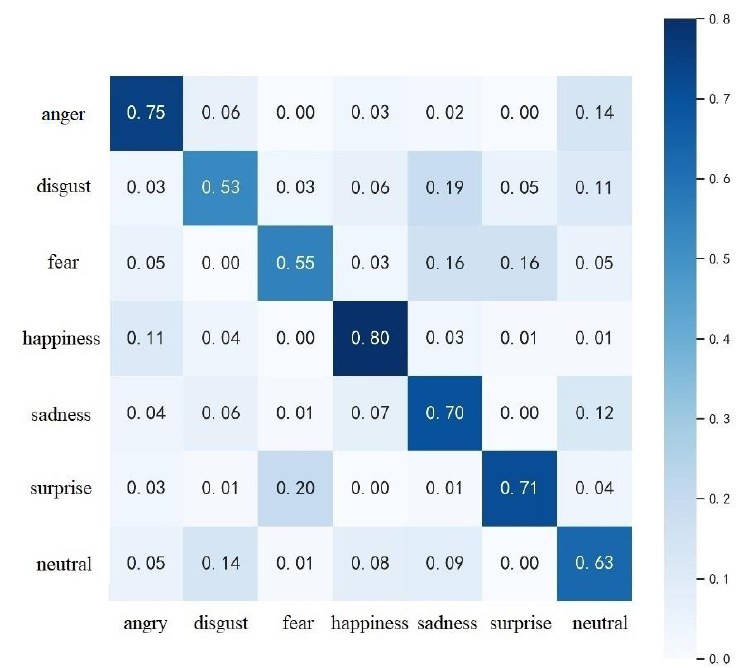
Figure 7. Confusion matrix for the AFEW dataset.